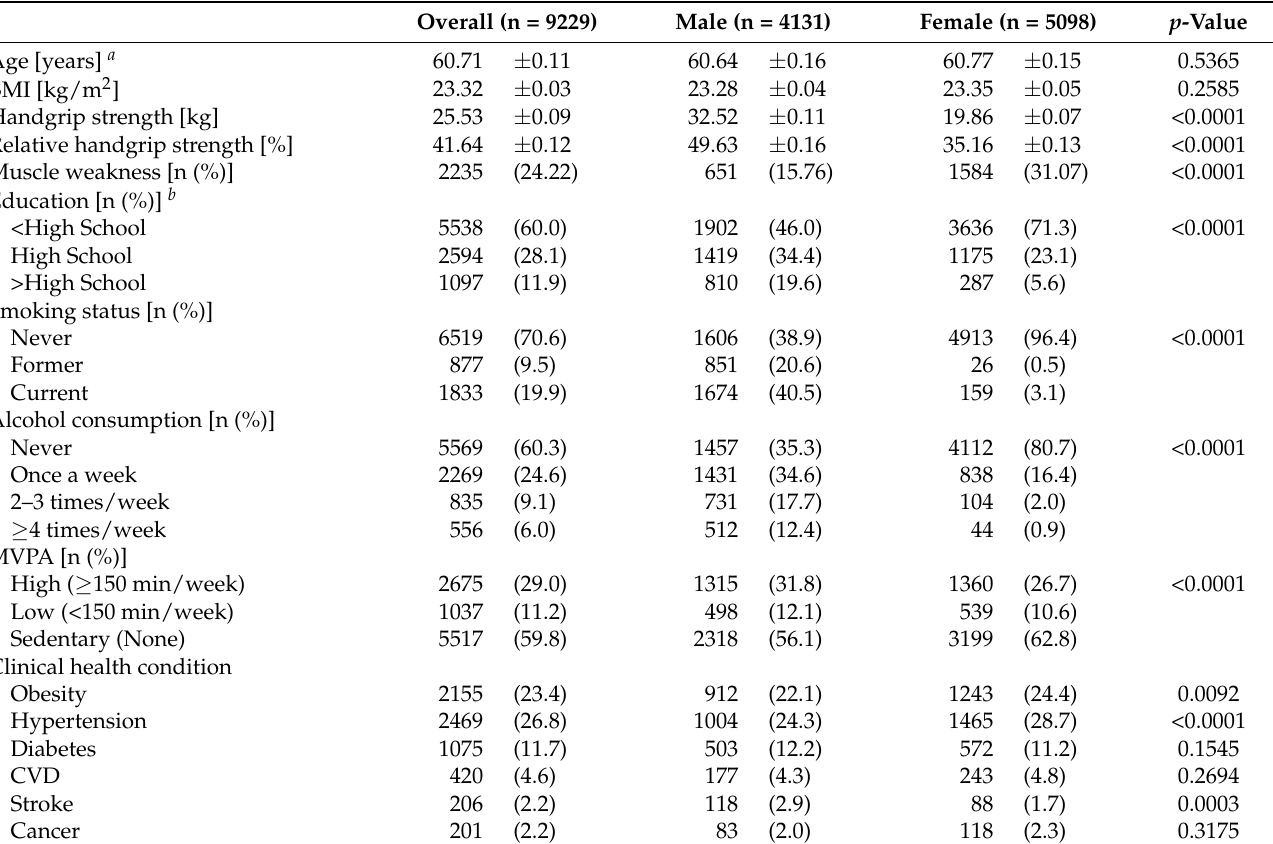
Table 1. Participant